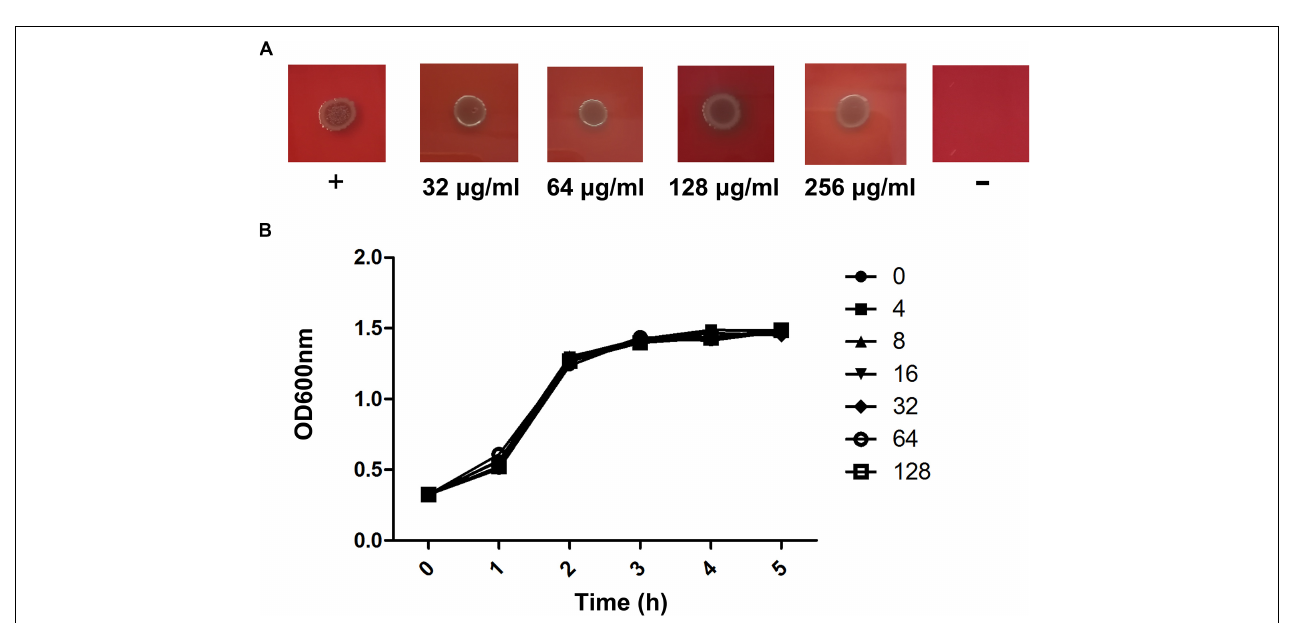
FIGURE 2 | Verbascoside has no influence on the growth of C. perfringens . (A) The MIC value of verbascoside against C. perfringens ATCC13124 was determined by agar dilution. (B) Growth curves for the C. perfringens strain ATCC13124 administered different concentrations of verbascoside were examined by monitoring the OD600 nm of each sample every 60